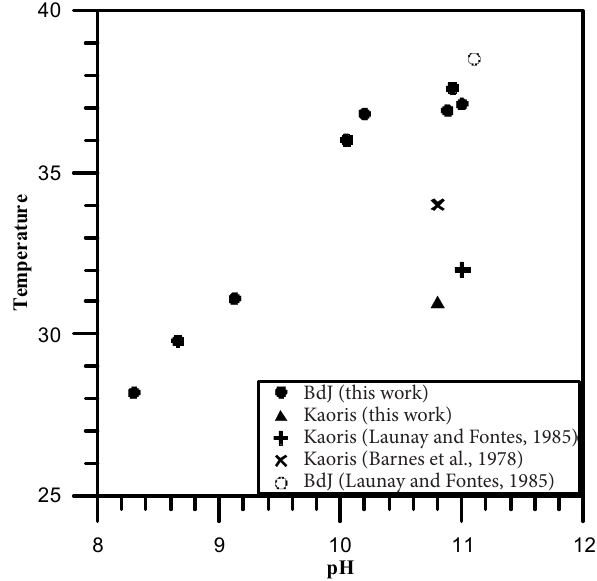
Figure 3. In situ temperature of Prony Bay water samples versus